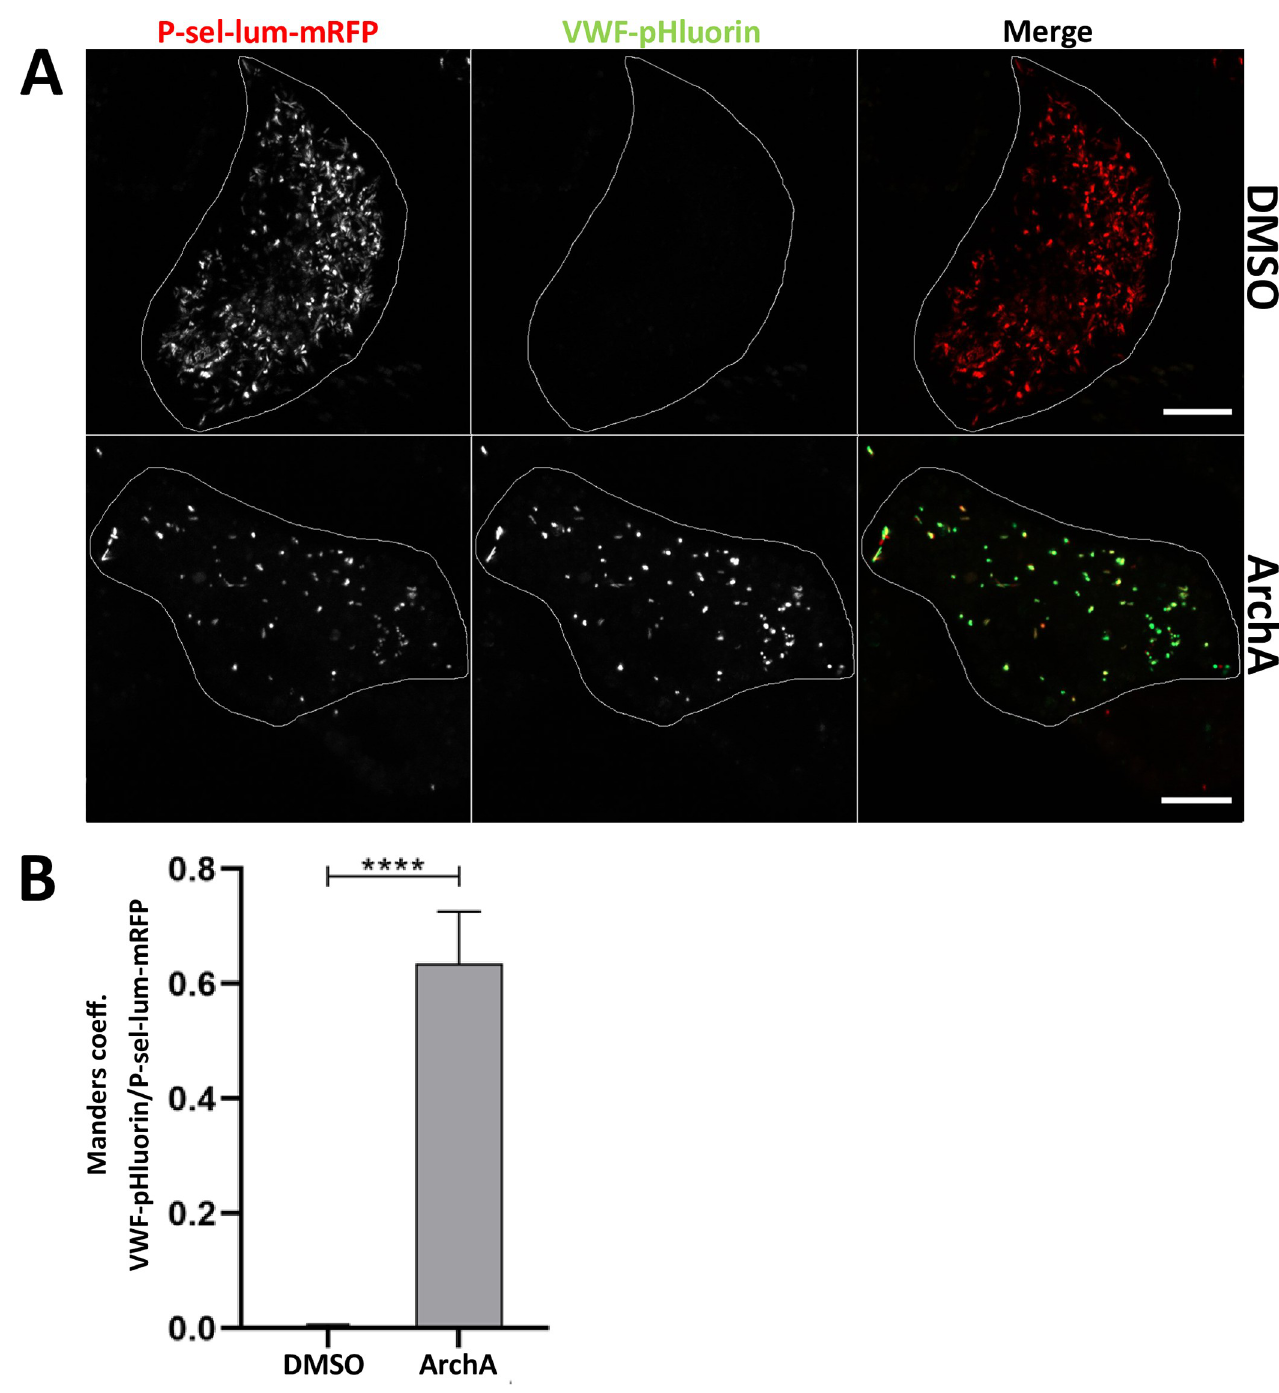
Fig 3. The V-ATPase-specific inhibitor archazolid A interferes with WPB acidification. A. HUVEC expressing P-sel-lum-mRFP and VWF-pHluorin were incubated with 0.02% DMSO (upper panel) or 2 nM ArchA (lower panel), respectively, at 37˚C for 24 h and subsequently analyzed via live cell microscopy. Shown are images of maximum intensity projections of z-stacks. Cell circumferences are indicated by lines. Scale bars: 10 μ m. B. The degree of colocalization of the mRFP and pHluorin fluorescence signals was quantified by determining Manders coefficient 1 which corresponds to the fraction of P-sel-lum-mRFP overlapping with VWF-pHluorin. n = 30. Bars indicate the median. Error bars show 95% confidence interval. Statistics were conducted using a Mann-Whitney test. ���� p � 0.0001, ��� p � 0.001, �� p � 0.01, � p � 0.05.